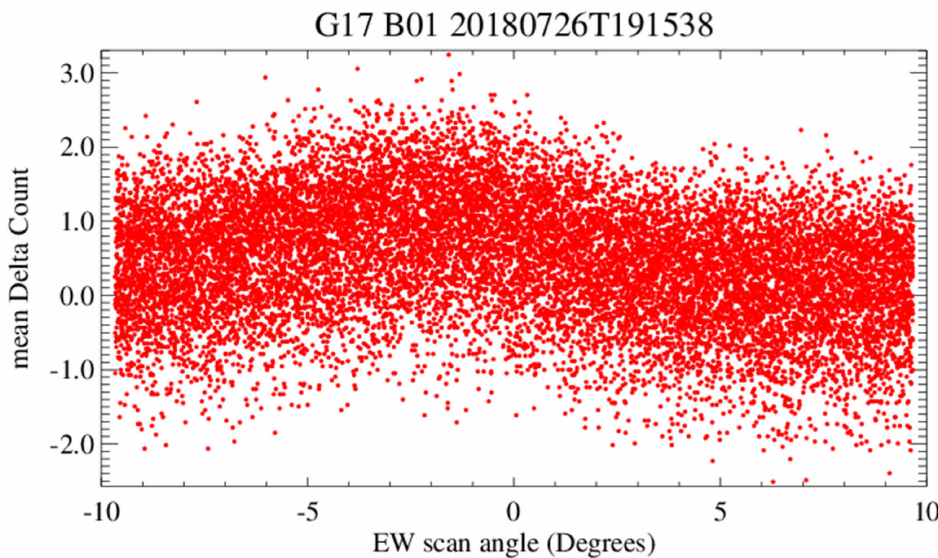
Figure 17. Change in the delta count with the scan angle for the samples at the northern part of FD Swath #11. Delta count is the count difference between a swath sample and the corresponding spacelook calculated with Equation (2). Each dot is the mean value for the samples from the northern part of Swath #11 (lines #350–636 in Figure 12) at the same EW scan angle (vertical line). Data were collected at 19:15:38 UTC on 26 July